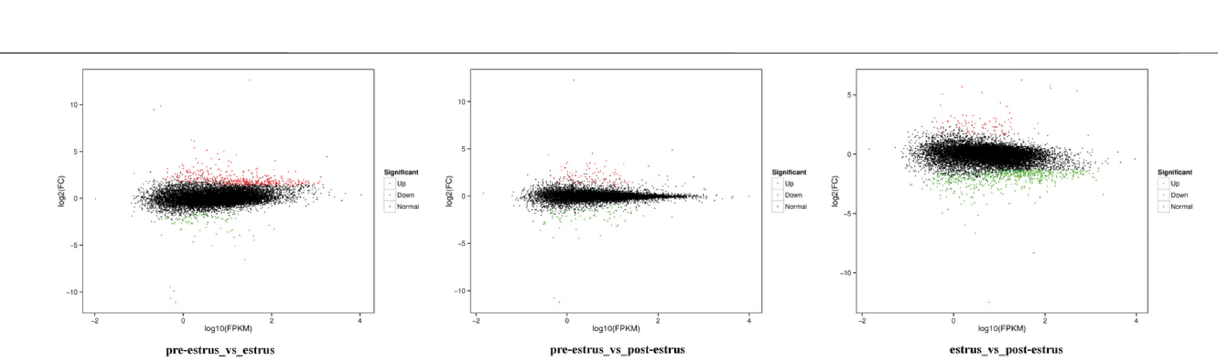
FIGURE 4 | Cluster analysis of all differentially expressed genes. (A) Differentially expressed genes between the prepuberty (T01, T02, and T03) and puberty (T04, T05, and T06) groups. (B) Differentially expressed genes between the prepuberty (T01, T02, and T03) and postpuberty (T07, T08, and T09) groups. (C) Differentially expressed genes between the puberty (T04, T05, and T06) and postpuberty (T07, T08, and T09) groups.